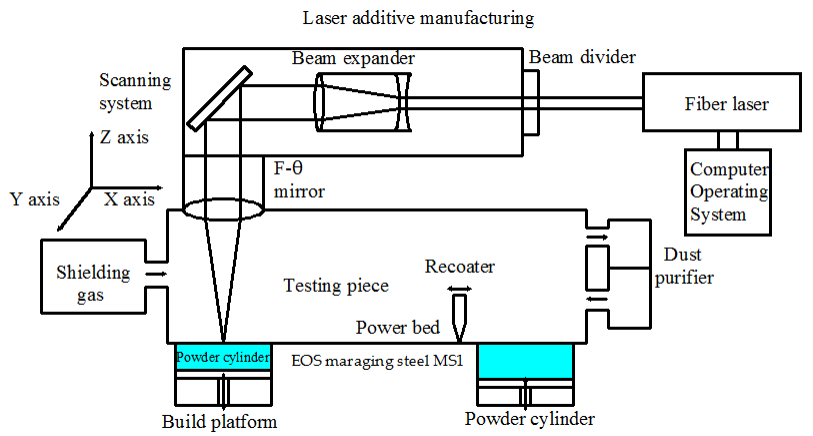
Figure 1. Metal additive manufacturing of high-strength metal material based on selective melting.